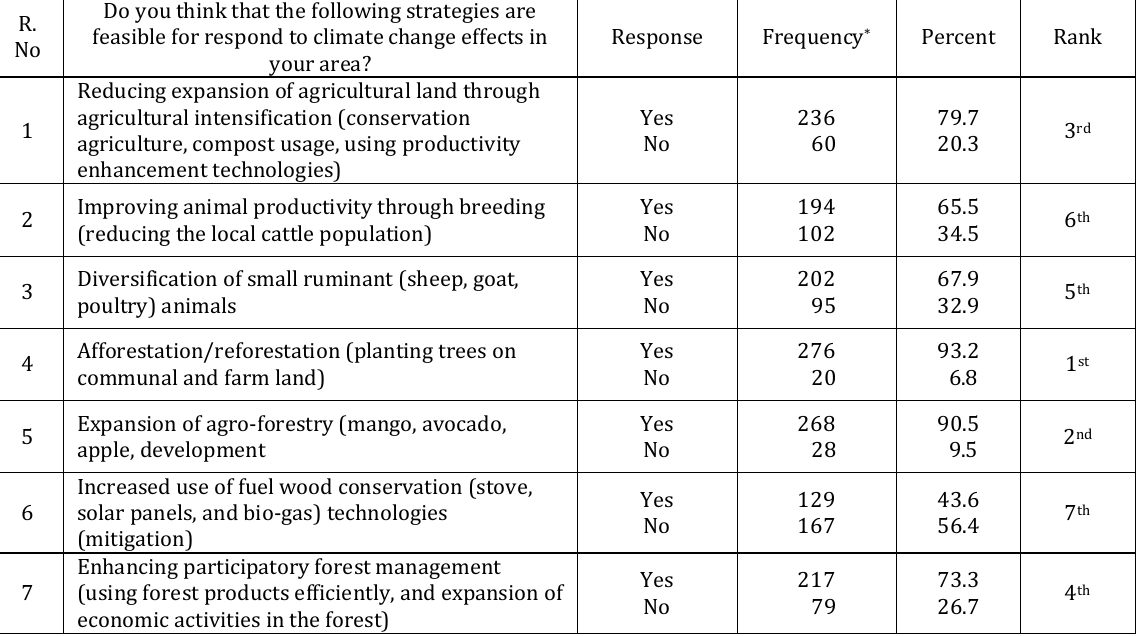
Table 8. Perceptions of respondent towards climate change mitigation strategies (Source: survey, April 2018)